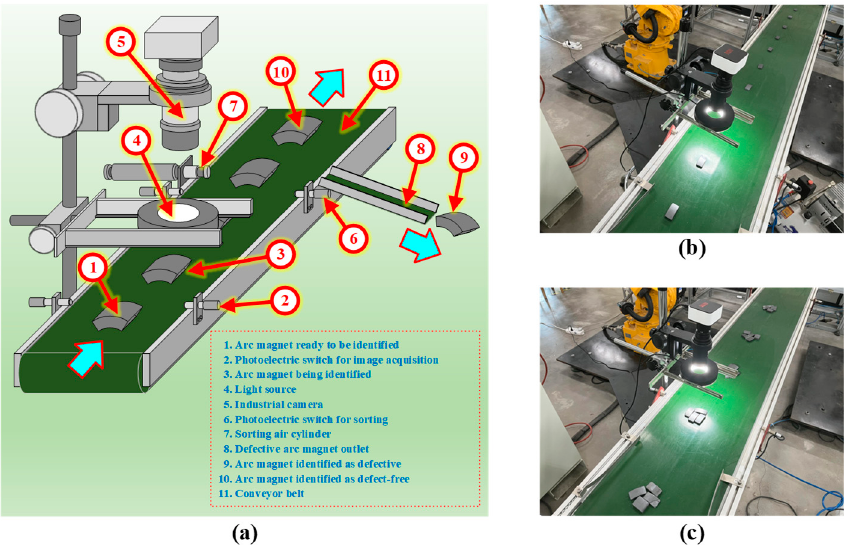
Figure 3. The experimental rig designed to identify the surface defects on arc magnets: ( a ) the three- dimensional diagram; ( b ) partial actual details of the individual identification of each arc magnet; ( c ) partial actual details of the simultaneous identification of multiple arc magnets.